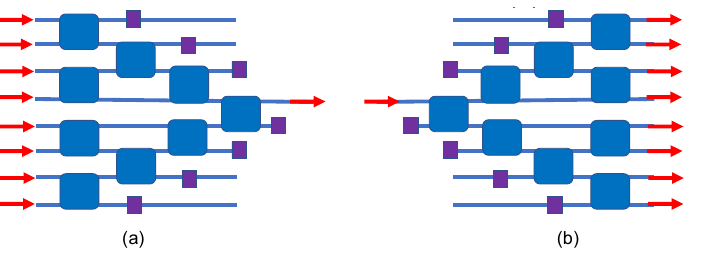
Figure 9. IDC block diagram on monochromatic ( a ) 8 × 1 and ( b ) 1 × 8 spatial routing switches.